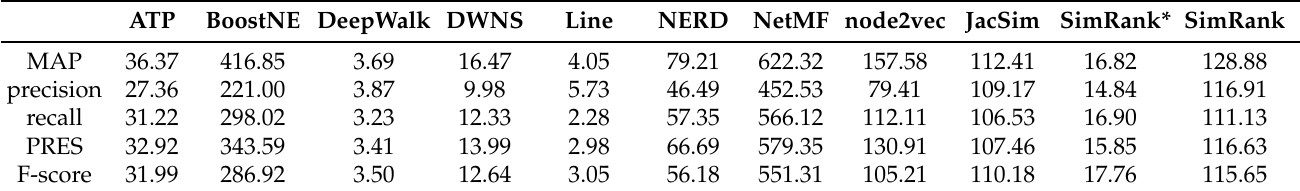
Table 7. Accuracy improvements (%) by JPRank over other methods with the Cora dataset.